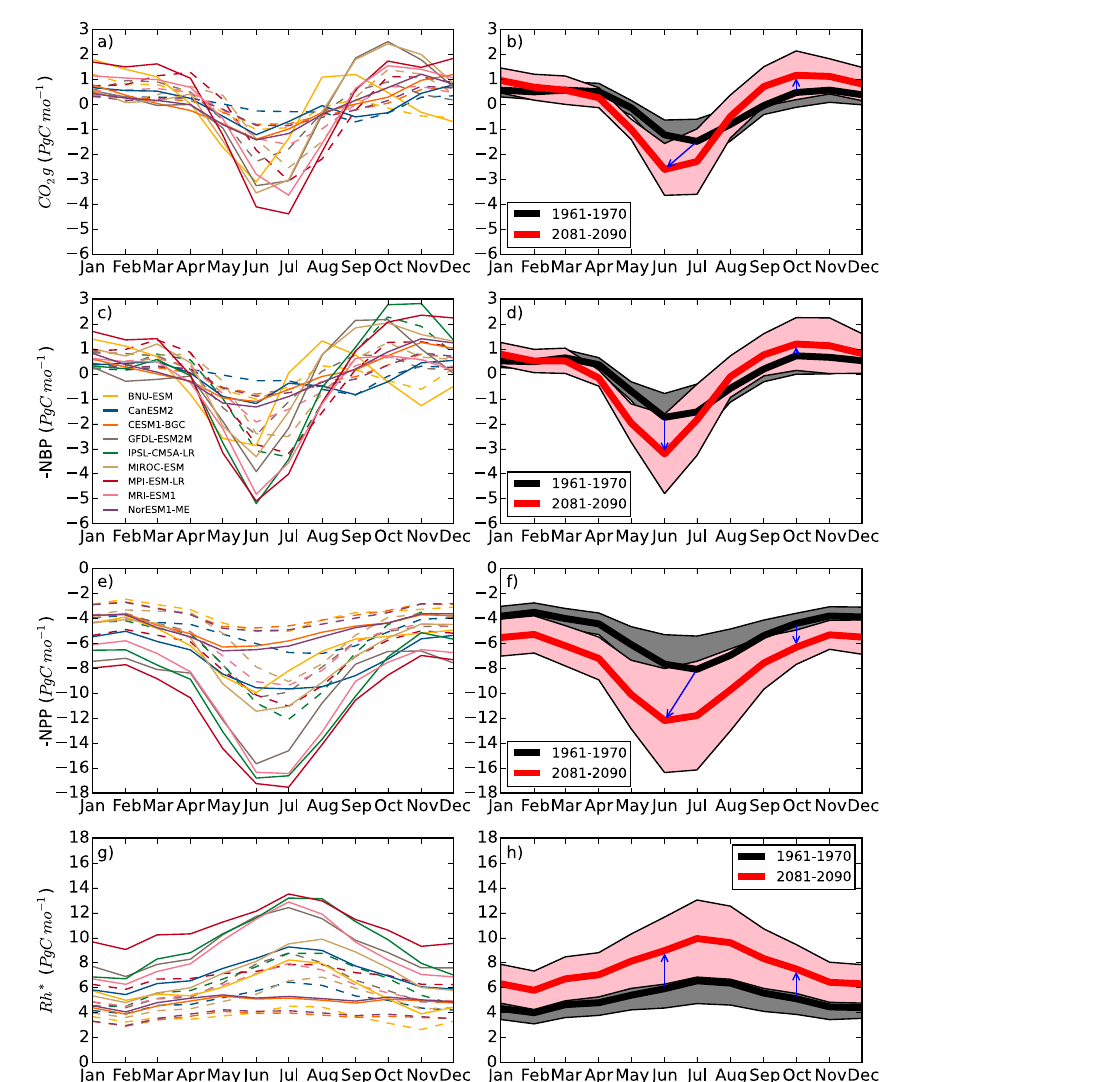
Figure 3. Seasonal cycle of detrended global mean CO 2 growth rate ( a and b ), global total − NBP ( c and d ), global total − NPP ( e and f ), and global total R ∗ ( g and h , computed as NPP minus NBP), averaged over 1961–1970 and 2081–2090 for the CMIP5 models (excluding h INM, also excluding IPSL for CO 2 growth rate). Seasonal cycles of individual models are presented in the left panel (dashed for 1961–1970, and solid for 2081–2090). Ensemble mean and one standard deviation model spread (black/grey for 1961–1970, red/pink for 2081–2090) are displayed in the right panels. Blue arrows mark the changes in June and October (NBP maxima and minima), except for CO 2 growth rate and − NPP, where arrows also indicate phase shifts of minima between the two periods. We show − NBP and − NPP so that the negative values represent carbon uptake by the biosphere, and positive values indicate carbon release from the biosphere. Note that − NBP and its two components − NPP and R ∗ are not detrended, so that the sum of (f) and (h) equals to (d) . Detrended − NBP seasonal cycle (not shown) looks h very similar to (d) , as its trend is small compared to the magnitude of seasonal